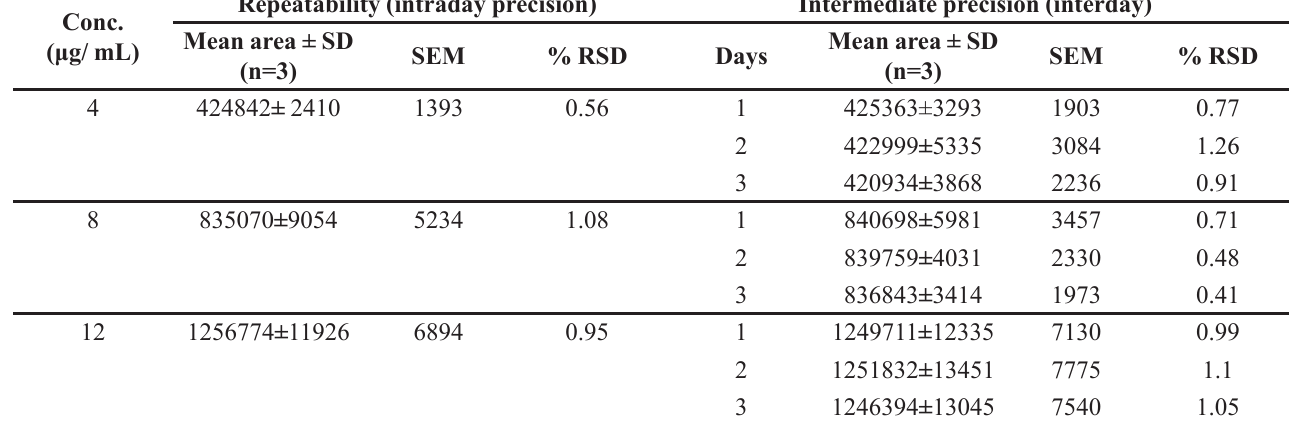
TABLE II - Precision of proposed method Conc.